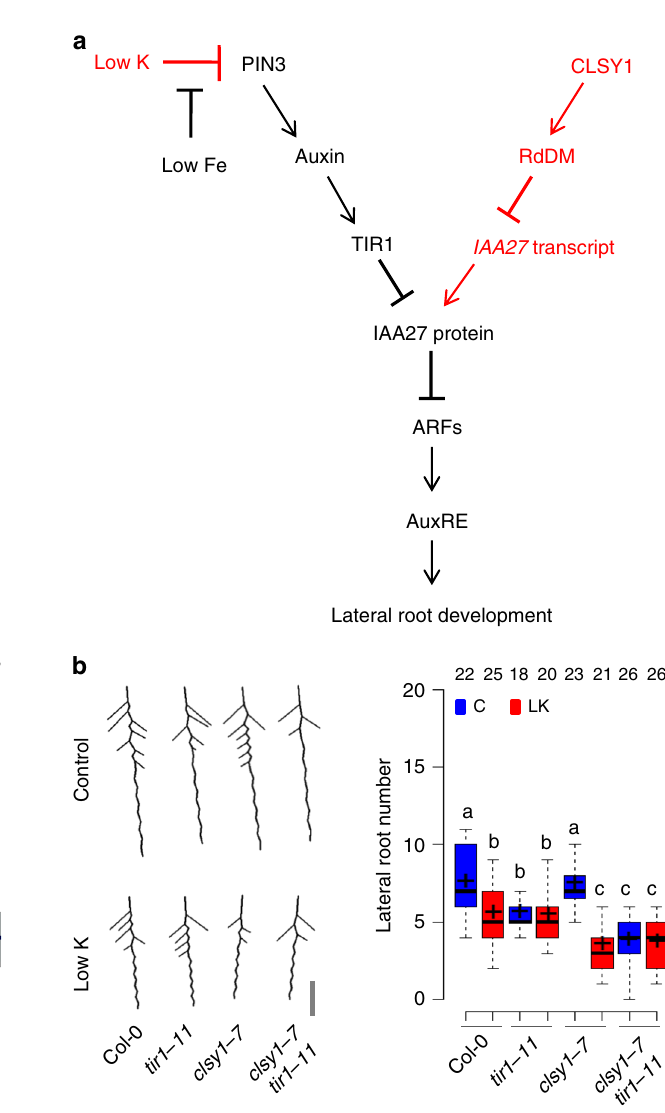
Fig. 7 CLSY1 maintains lateral root development when the auxin pathway is genetically disrupted. a Schematic summary of the proposed interaction between the canonical auxin pathway (black) and the CLSY1 -RdDM mediated backup pathway (red). Existence of the latter only becomes apparent when the auxin pathway interrupted by environmental or genetic perturbation. b Average root phenotypes and lateral root number of Col-0 wild type, clsy1 , tir1 and clsy1tir1 double mutants in control (C, blue) and low K (LK, red) conditions. The depicted average root architectures (scale bar 1 cm) were generated with EZ-Root-Vis software from individual plants grown in three independent experiments. The number of plants analysed ( n ) is indicated above the box plots. The centre lines are the medians of the data and crosses are the means; box edges are the fi rst and third quartiles; the whiskers extend to 1.5 time the interquartile range. Different letters denote signi fi cant differences at P < 0.05 (one-way ANOVA). The source data of b are provided in a Source Data fi